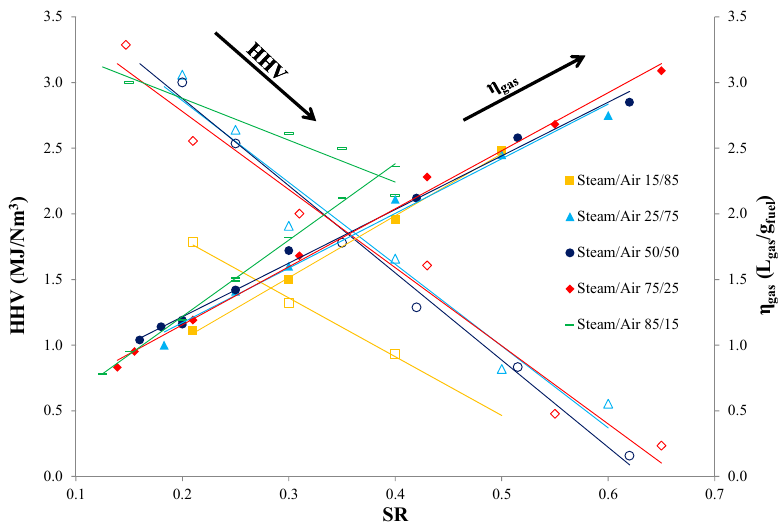
Figure 2. Gas yield and HHV of the gas obtained for PIN at different steam/air ratios.